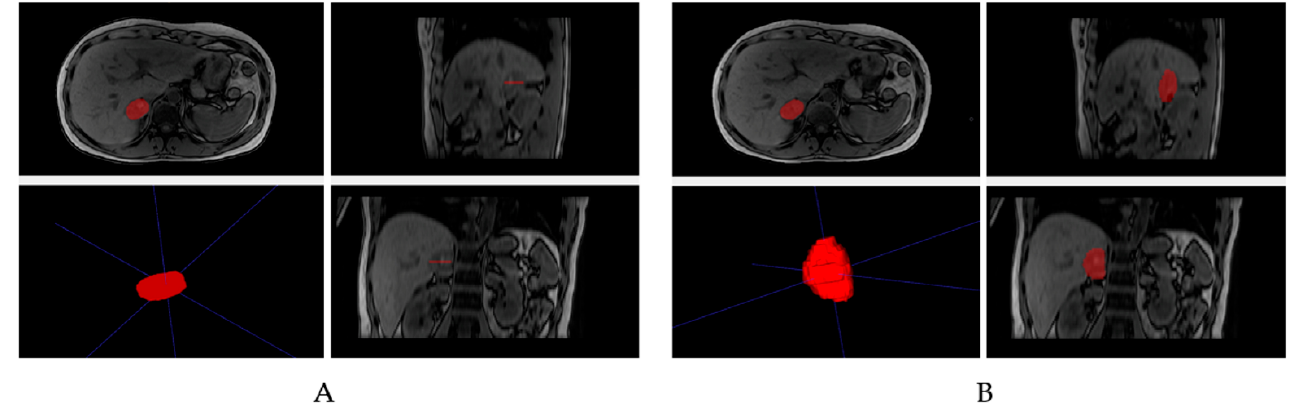
Figure 2. In this example, two-dimensional ( A ) and three-dimensional ( B ) approaches for adrenal lesion segmentation on magnetic resonance images are shown.